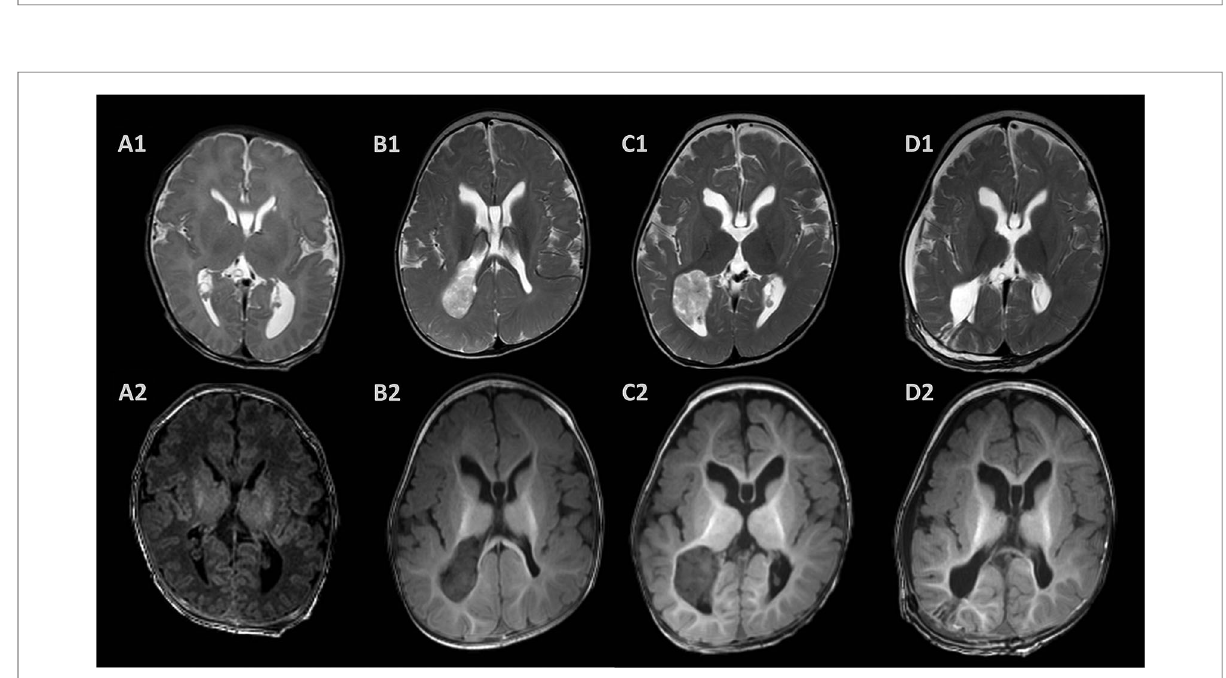
FIGURE 2 Prenatal magnetic resonance images. (1) T2-weighted image at 25 weeks of gestation. (2) T2-weighted image at 35 weeks of gestation. Axial ( A, B ) and coronal ( D ) images showed symmetrically dilated lateral ventricles, and corpus callosum agenesis (black arrow); sagittal ( C ) images showed abnormal morphology of the right ventricle.